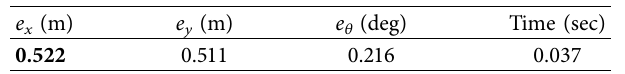
Table 7: The mean of numerical readings with the EKF (two landmarks and non-Gaussian